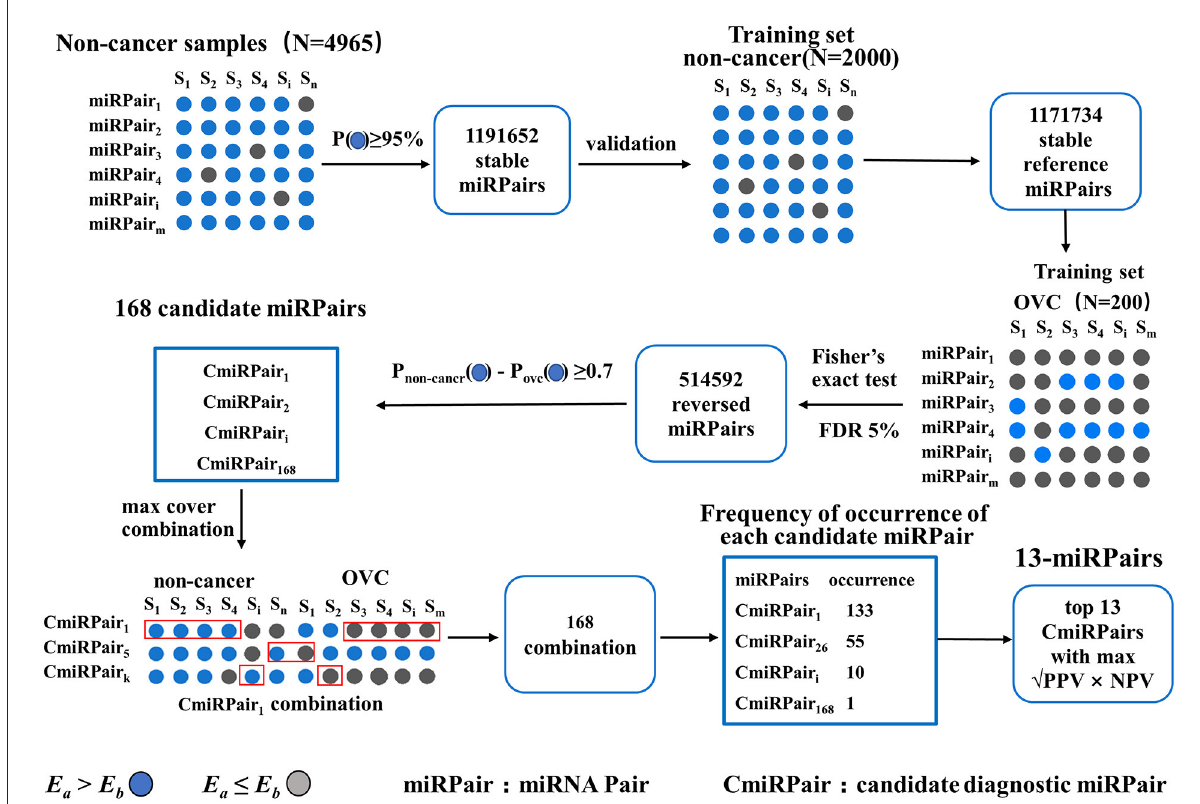
FIGURE2 Steps of constructing 13-miRPairs and their detailed